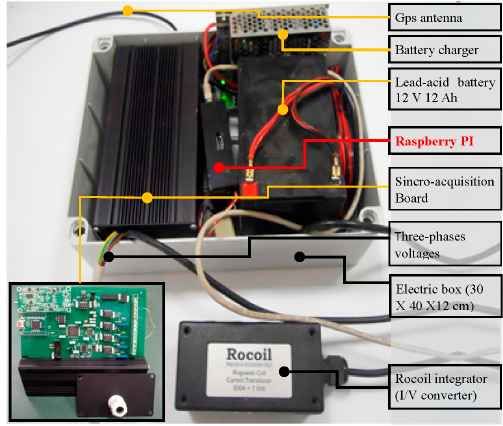
Figure 8. Image of the instrument placed in its box; the detail of the acquisition card is also shown.